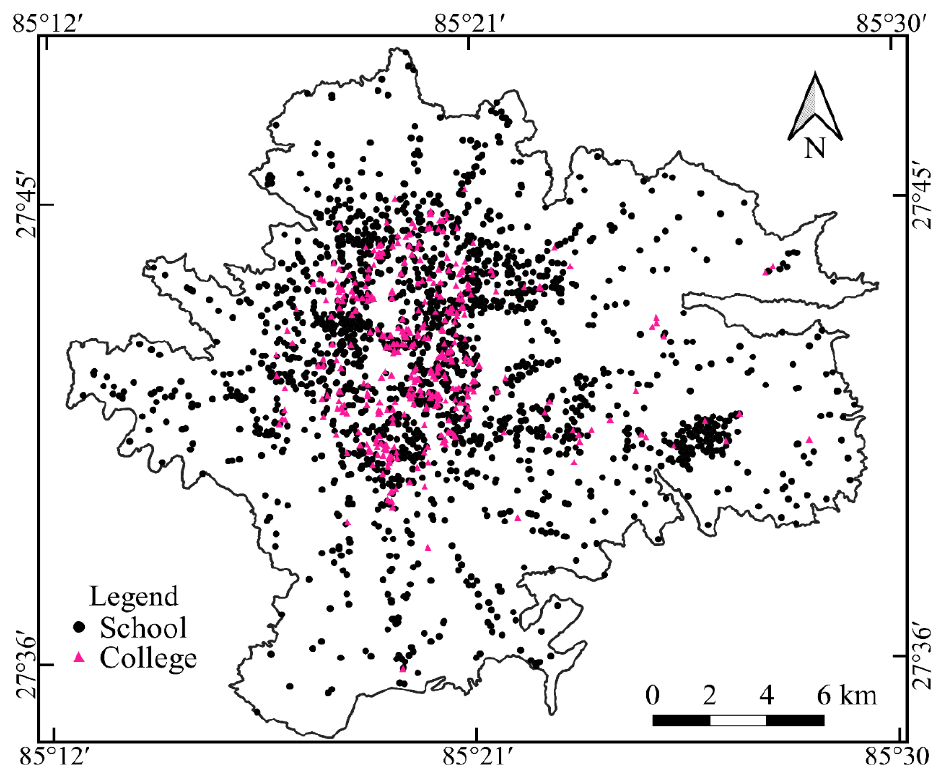
Figure 7. Schools and colleges in Kathmandu Valley.